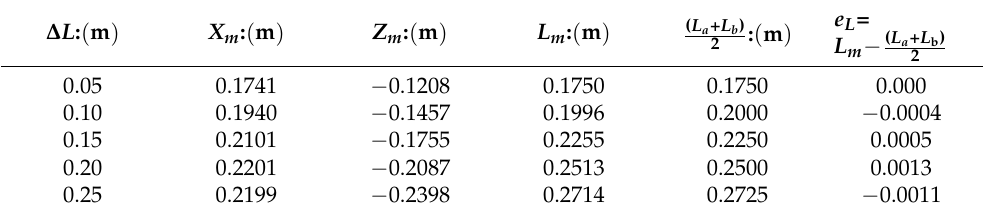
Table 2. The length of the assumed backbone in difference ∆ L (data from experiment, L b = 0.15 m).